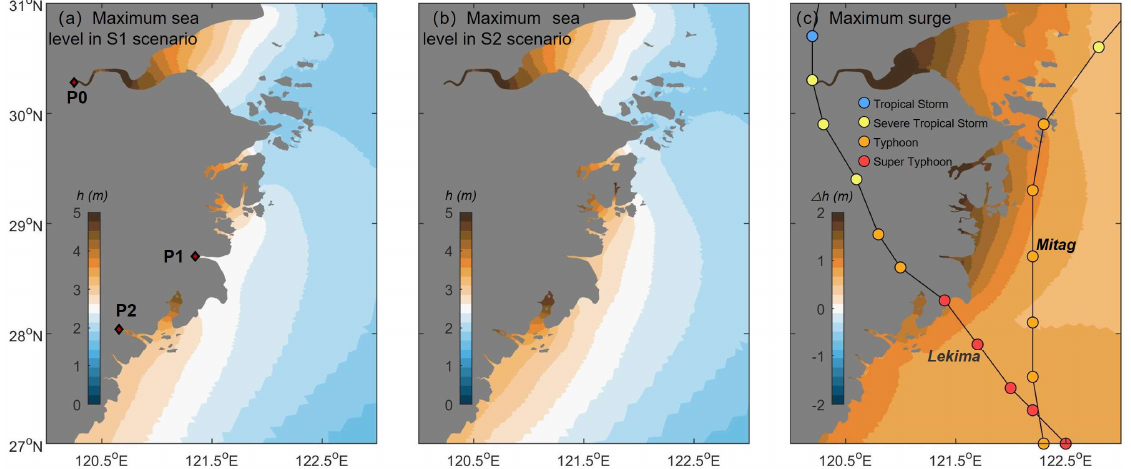
Figure 3. Maximum sea water level in ( a ) S1 and ( b ) S2 scenario during the year 2019; ( c ) the maximum differences in sea water level between S1 and S2. The maximum values occurred during the typhoon periods. Results were extracted from hourly simulations. Typhoon tracks of Lekima and Mitag are shown in ( c ). Red rhombi in ( a ) indicate the analysis points P0–P2 in the following